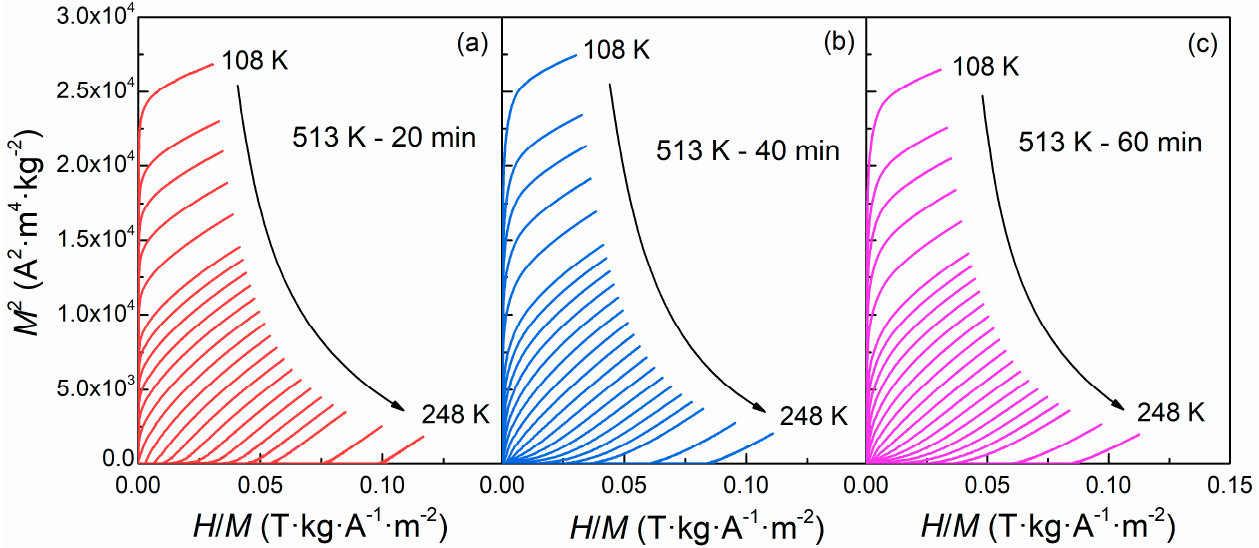
Figure 4. Arrott plots of the multi-phase Gd 60 Co 40 alloy annealed at 513 K for ( a ) 20, ( b ) 40 and ( c ) 60 min.